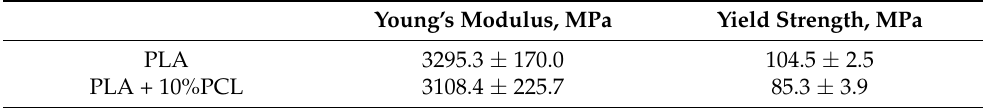
Figure 4. Compression curves for a polymer blend PLA + 10%PCL and PLA.